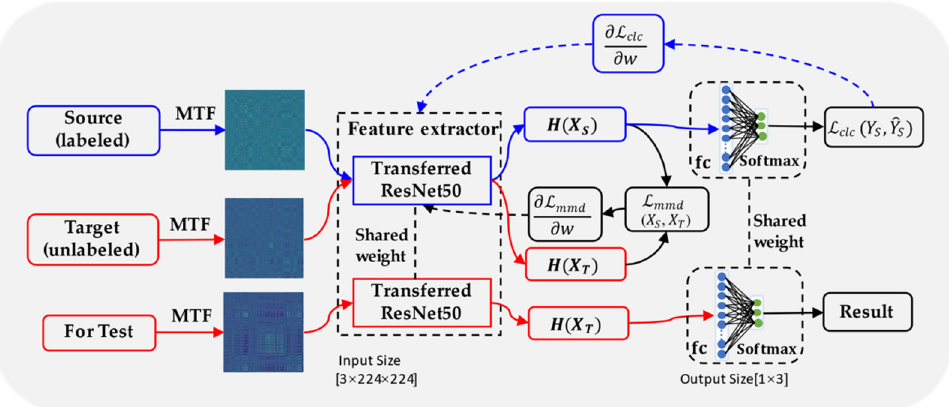
Figure 3. The MTF-DDAN framework. H represents the high-dimensional features extracted by the deep network, L clc ( Y S , ˆ Y S ) refers to the classification loss function, Y S , ˆ Y S represent source label and predicted label, respectively, L mmd ( X S , X T ) stands for MMD loss function, and X S and X T represent source and target data, respectively.